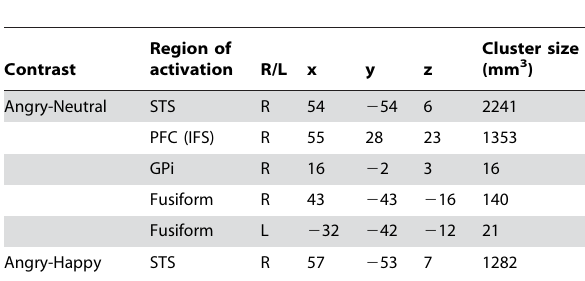
Figure 4. Coronal view shows bilateral fusiform activity obtained from the angry minus neutral contrast (regions outlined by black squares). Activity is greater for angry compared to neutral faces. Bars represent 6 1 standard error. doi:10.1371/journal.pone.0003536.g004 The angry minus neutral functional contrast showed the same pattern of activation as the main effect of emotion (higher activity for angry than neutral faces in rSTS, rPFC, and rGPi), but in addition this contrast revealed significantly greater angry vs. Table 2. Talairach coordinates and voxel cluster size values for specific emotion contrasts (FDR ,